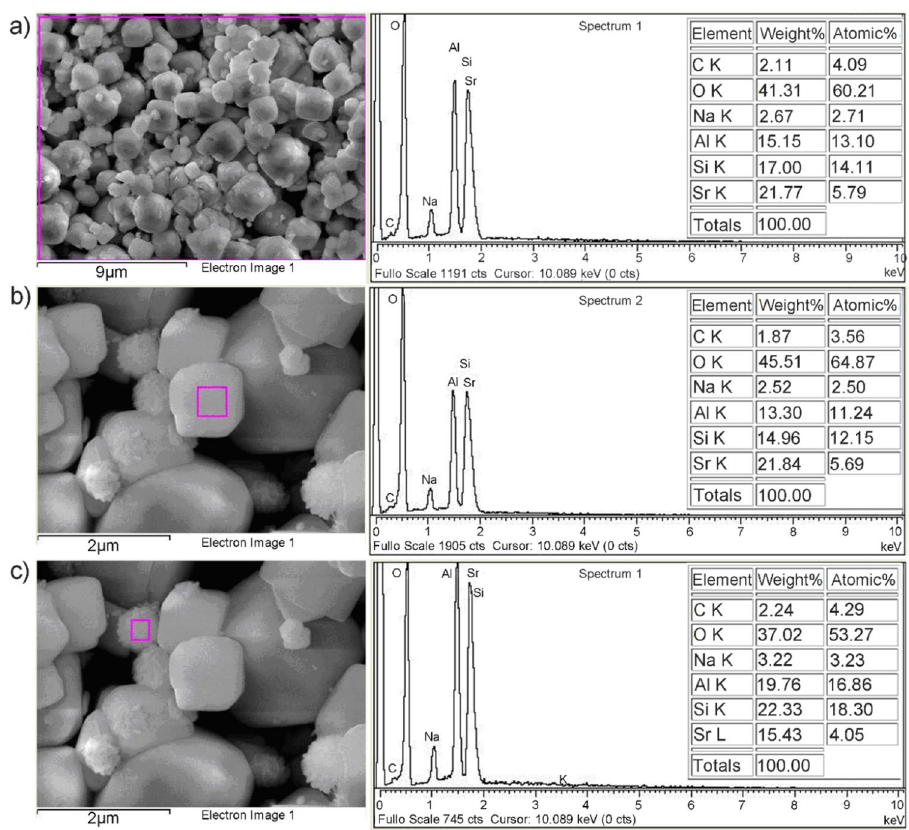
Figure 5. SEM/EDS analysis of Z4A after saturation with Sr: ( a ) bulk sample, ( b ) isolated cubic particle, and ( c ) isolated spherical particle.